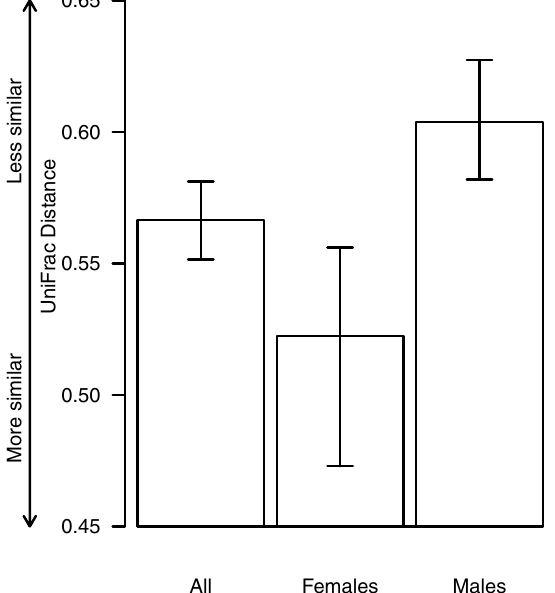
Figure 3. Mean UniFrac distances between pairs of samples that are in extreme quartiles of urinary arsenic for all babies who were formula-fed, for formula-fed males only and for formula-fed females only. Bars represent bootstrapped 95% confidence intervals around the